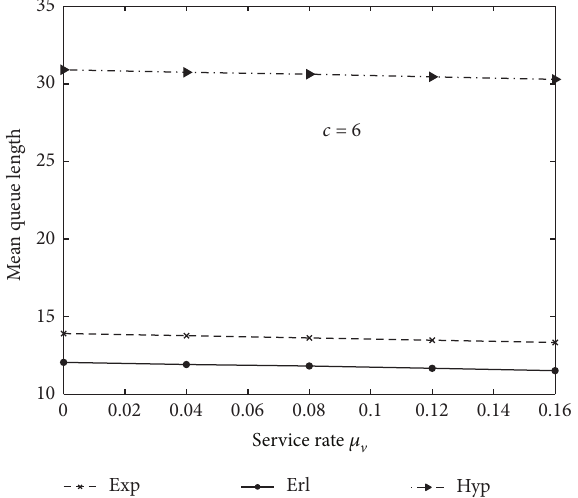
Figure 8: Mean queue length versus vacation-service rate with 𝜌 = 0.1 , 𝜉 = 10 , 𝜃 = 0.1 , and 𝑐 = 3